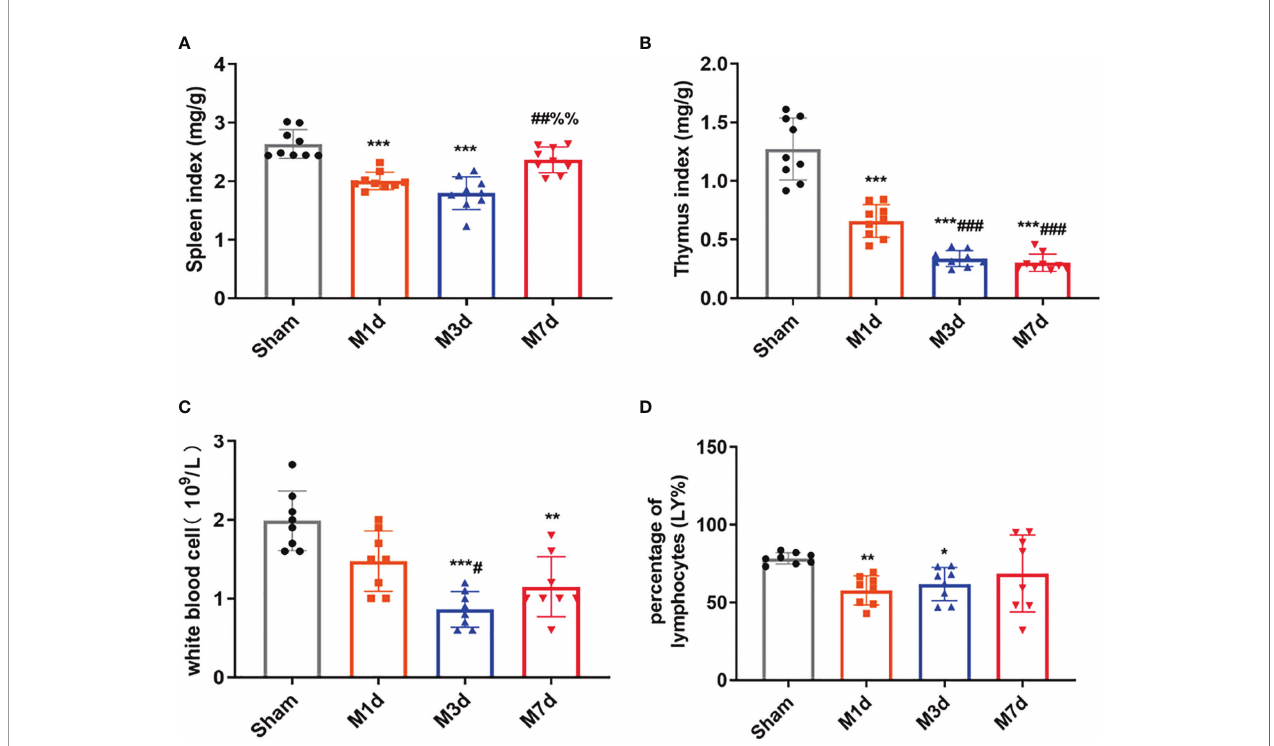
FIGURE 3 | Changes in immune function in the ICH model at different time points. (A, B) Changes in the spleen and thymus indices in ICH mice (n = 9). (C, D) WBC count and lymphocyte percentage (LY%) in peripheral blood were detected by a routine blood analyzer (n = 8). Data are expressed as the mean ± standard deviation. (A – D) Brown-Forsythe test and Welch ’ s ANOVA, Dunnett ’ s T3 multiple comparison test; * P <0.05, ** P <0.01, *** P <0.001 vs. the sham group; # P <0.05, ## P <0.01, ### P <0.001 vs. the M 1 d group; %% P <0.01 vs. the M 3 d